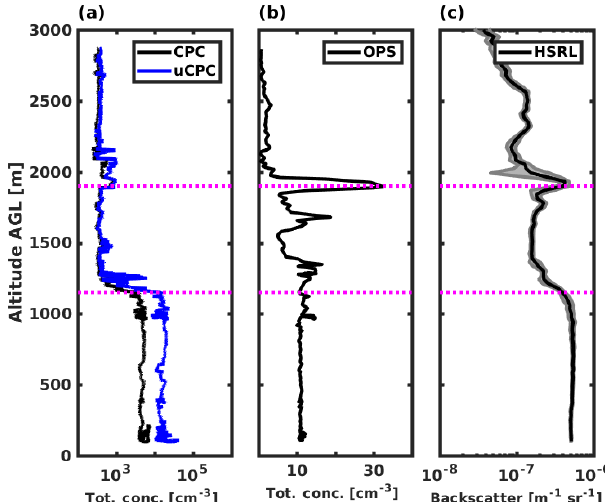
Figure 5. Vertical profiles of (a) total particle concentration mea- sured by uCPC and CPC, (b) total particle concentration mea- sured by OPS, (c) HSRL backscatter coefficient averaged over the time taken for the Cessna ascent over Hyytiälä, Finland, on 10 April 2014. All panels show a presence of a thin layer at 1900m (dashed magenta line) with OPS indicating enhanced contribution of larger (0.3–5µm)